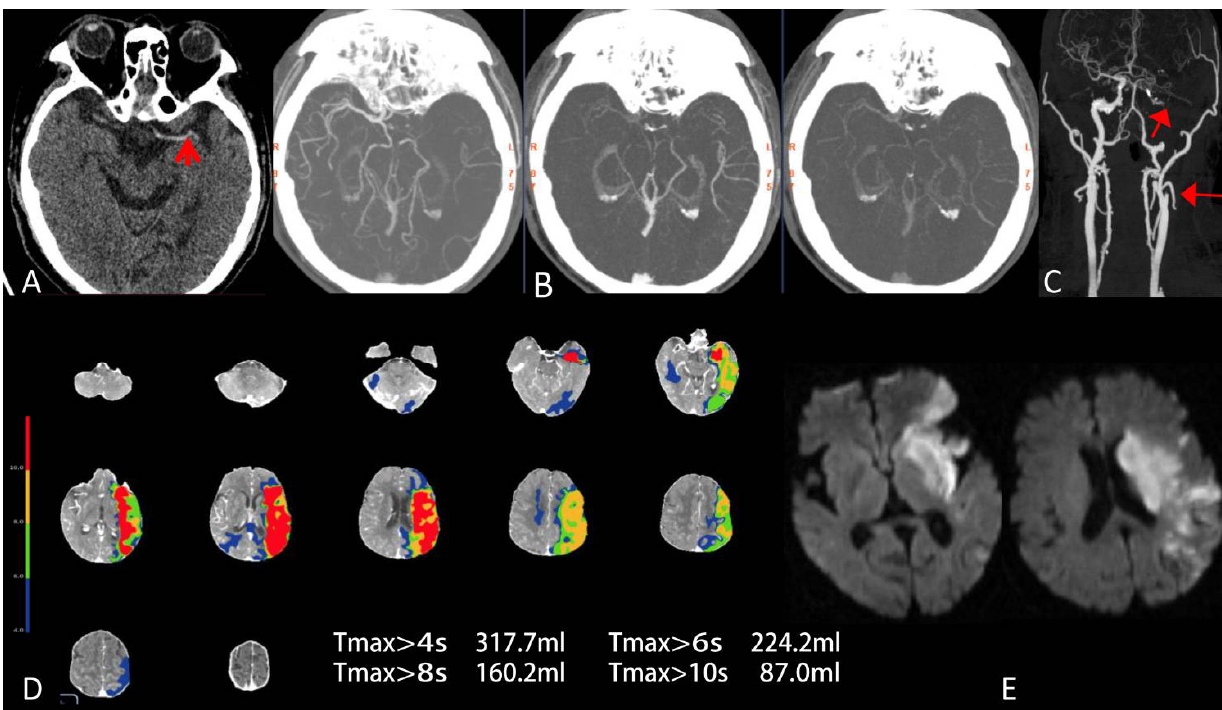
Figure 3. Baseline mCTA, CTP and follow-up DWI in a 79-year-old man with acute ischemic stroke within 6 h after onset and received intravenous alteplase treatment. The time from onset to CT scan was 7.5 h. The baseline NIHSS score was 14 and the ASPECTS on NCCT was 6. ( A ) The high density sign of the middle cerebral artery can be seen in the left temporal lobe on NCCT images (red arrow). ( B ) The mCTA axial MIP shows moderate collateral vessels within the left temporal parietal lobe and a two-phase delay in the filling of peripheral vessels. The mCTA collateral score was 3 (unfavorable collateral status). ( C ) Coronal MIP reconstruction of neck CTA shows severe occlusion of the left internal carotid artery C1 segment to M1 segment of MCA (red arrow). ( D ) Tmax map shows the severe hypoperfusion area (red) defined Tmax > 10 s was relatively large near 87 mL and a hypoperfusion area (light green) defined Tmax > 6 s was 224.2 mL, while HIR (=0.39) was high. ( E ) Family members of the patient refused EVT and this patient had a FIV of 76 mL on the left hemispheric region on DWI. The 90 d mRs score of this patient was 4 (severe disability). Table 1. Baseline Patient Characteristics and Comparison of Clinical Variables Stratified by Func- tional Outcome.